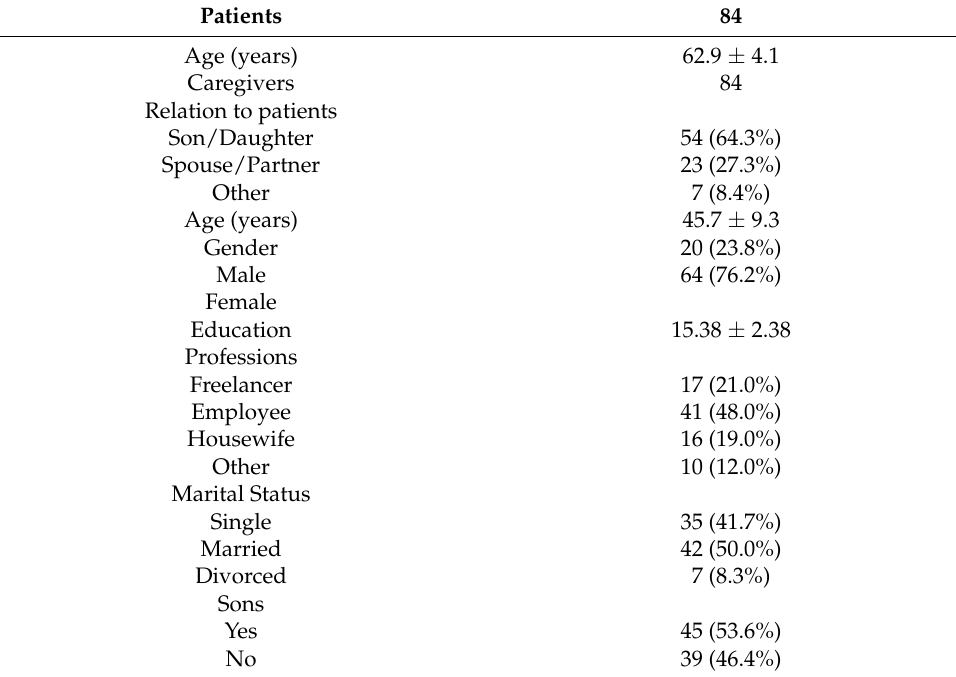
Table 1. Descriptive analysis of patients’ and caregivers’